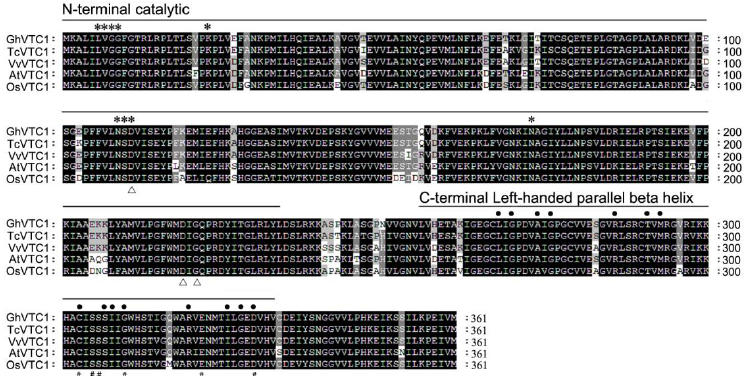
Figure 2. Amino acid sequence alignment and conserved domain analysis of Gossypium hirsutum GhVTC1 protein. The protein sequences used for alignment were obtained from Genbank or the Joint Genome Institute (JGI) database with the accession numbers as follows: GhVTC1, Gohir.D10G235400; TcVTC1, XP_007009211; VvVTC1, XP_002282422; AtVTC1, NP_001189713; OsVTC1, XP_015632712.